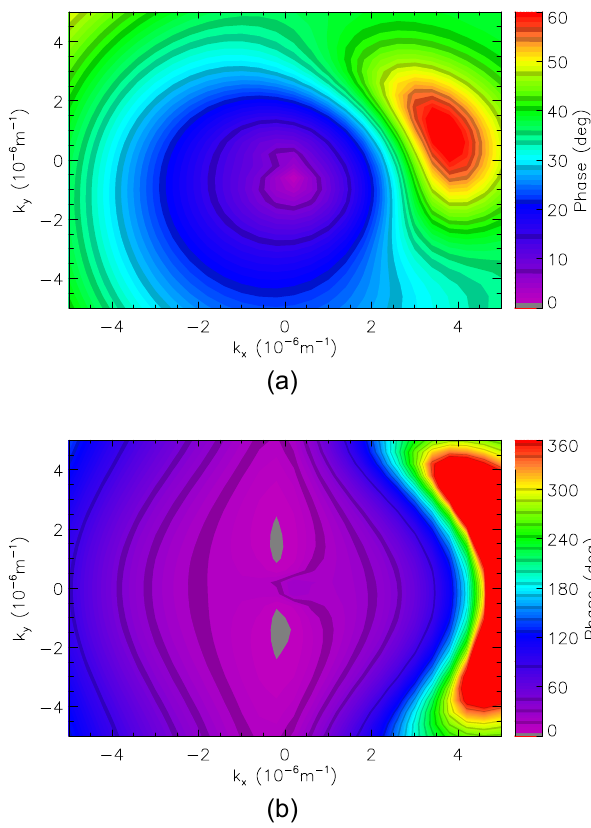
Fig. 5. The variation in differential phase for a 70MHz signal due to changes in TEC from a 15mHz ULF wave with ULF wave mix of 80% shear Alfv´en mode at 1000km altitude, as a function of the ULF wave spatial scale size. (a) Local noon using the divergence term only, (b) local morning (06:00LT) including the advection and divergence